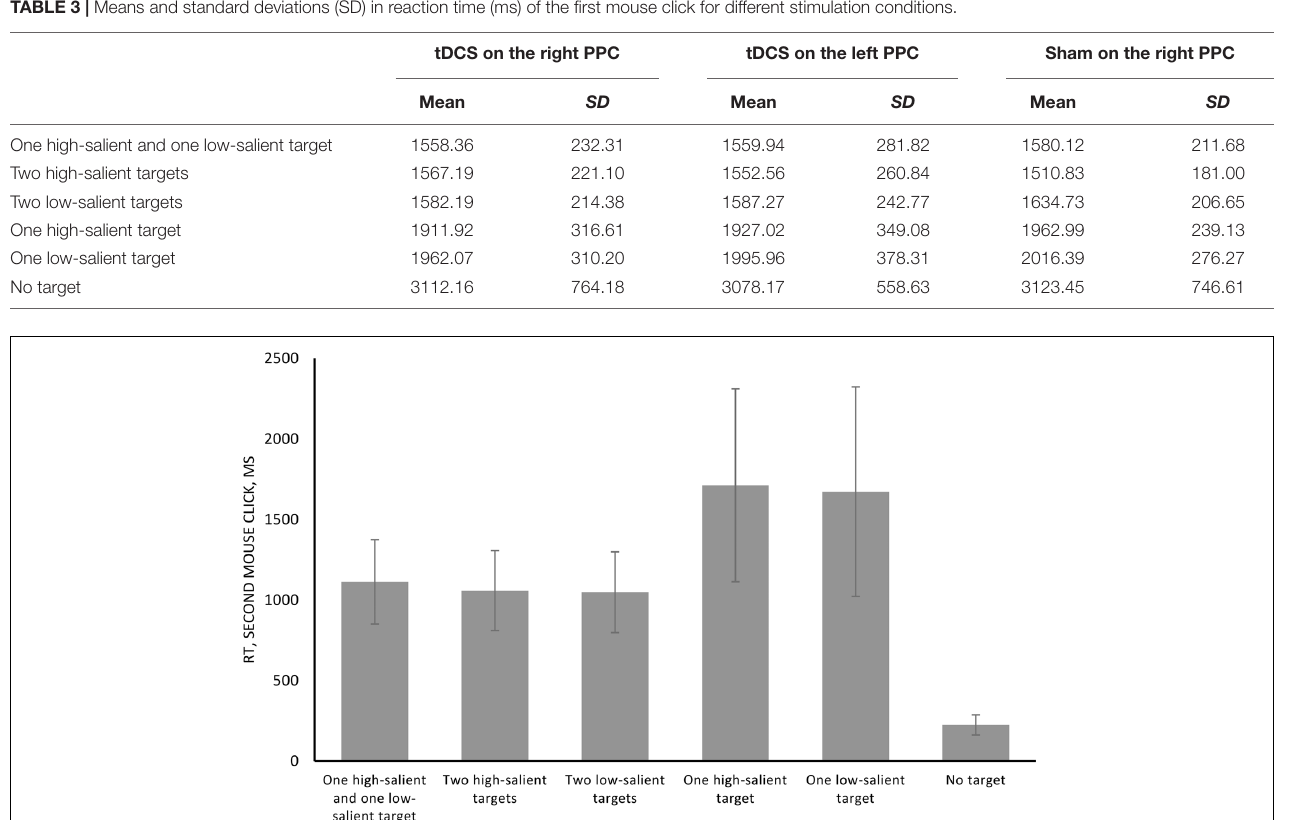
FIGURE 4 | Mean reaction time (ms) of the second mouse click collapsing different stimulation conditions. Error bars represent standard error of the mean.